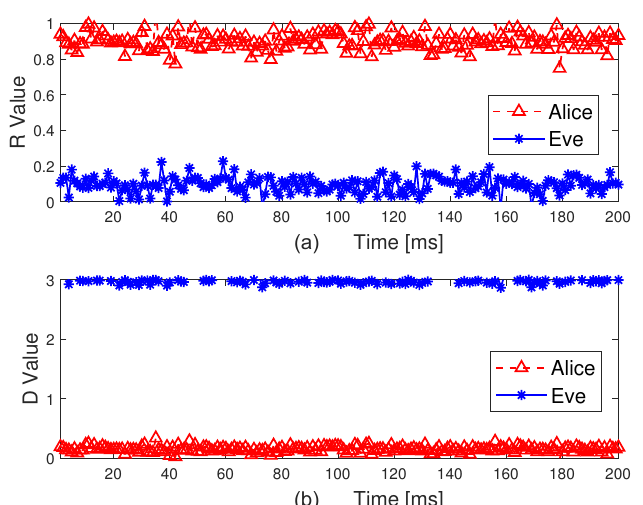
Figure 6. Normalized channel signal estimates of Alice and Eve.